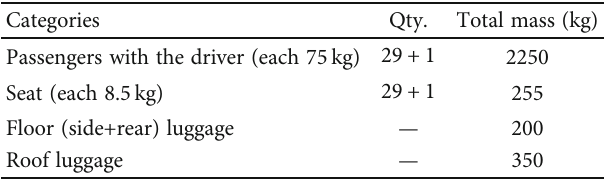
Table 3: Sum of masses applied on the bus structure.